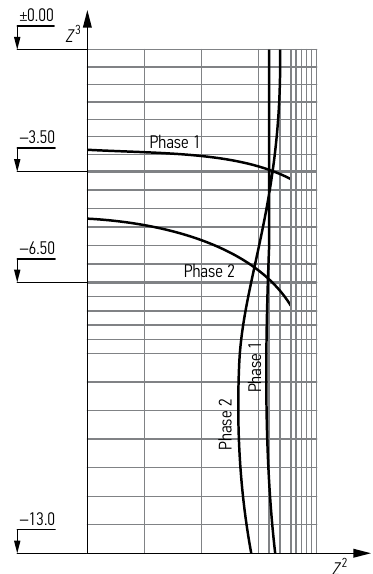
Fig. 4. The displacements characteristic diagrams of the retaining structure and the excavation bottom